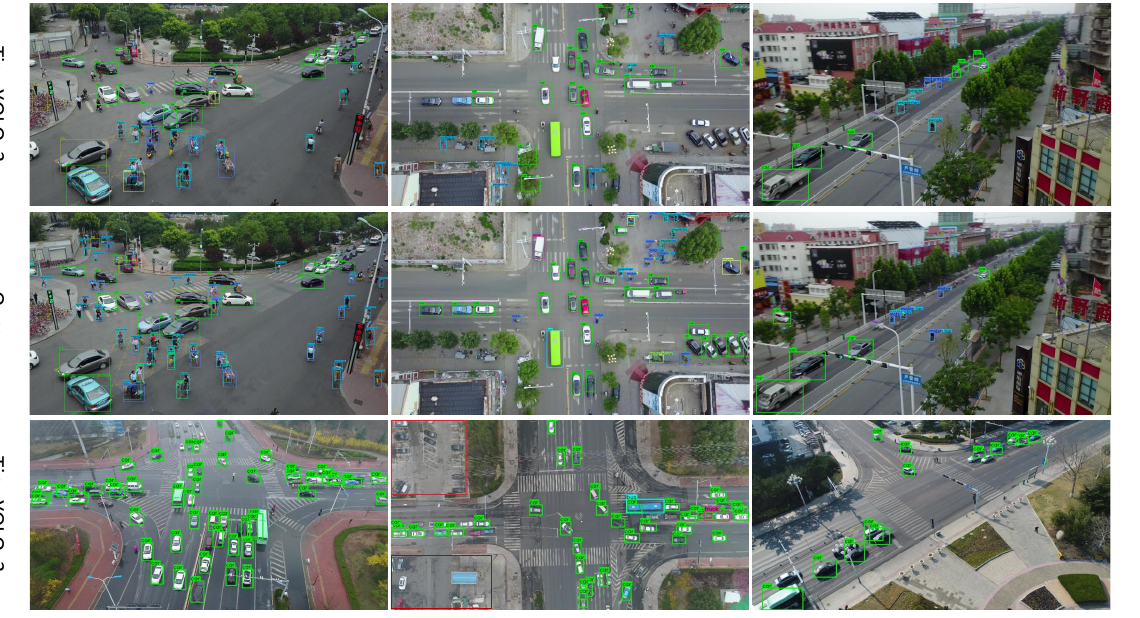
Table 6. Comparison of our method with the state-of-the-art Ligntweight or Anchor-free Methods on Visdrone-2018-vid and UAVDT-DET Datasets. Method Backbone Input